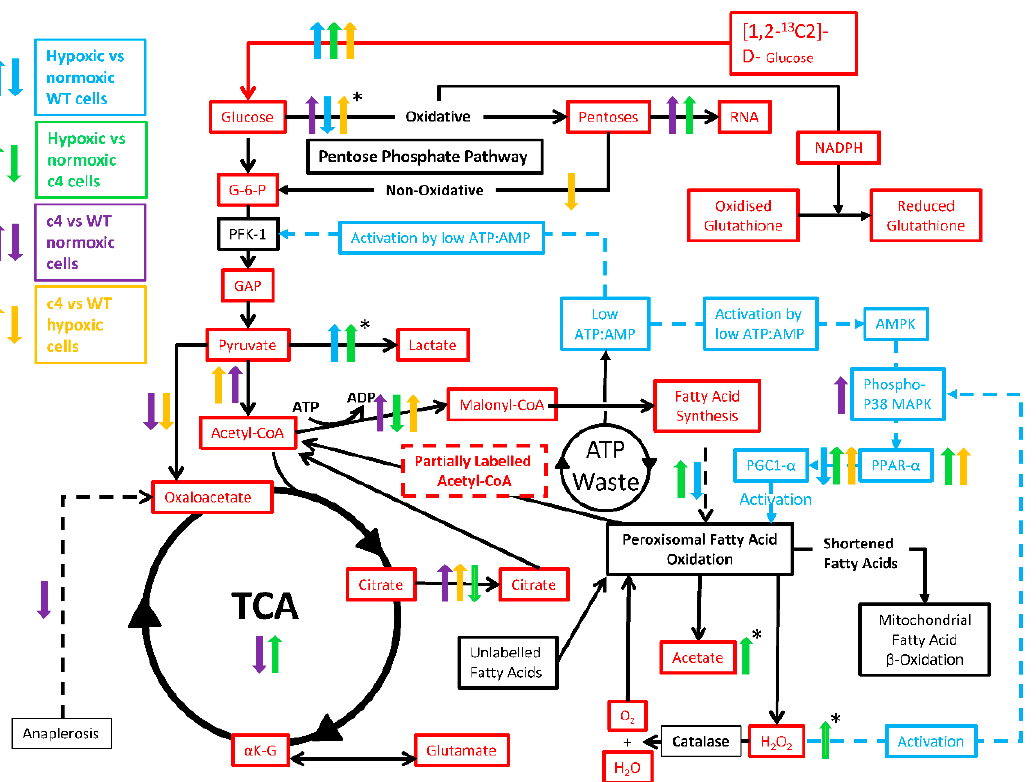
Figure 6. Metabolic fluxes and control factor expression changes in Hepa-1 cells. Solid black lines indicate metabolic pathways; dashed dark-blue lines indicate control mechanisms. Coloured up and down arrows indicate alterations in metabolic fluxes or changes in control factor expression compared with the corresponding parameter in WT or Hepa-c4 cells in normoxia: blue arrows, WT cells in hypoxia vs. normoxia; green arrows, Hepa-c4 cells in hypoxia vs. normoxia; purple arrows, Hepa-c4 cells vs. WT cells in normoxia; orange arrows, Hepa-c4 cells vs. WT cells in hypoxia. Differences in metabolic flux ( ↑ increased flux; ↓ decreased flux) due to HIF deficiency and hypoxia were inferred from changes in the relevant 13 C-labelled isotopomers; * ↑ and * ↓ fluxes were inferred from concentration changes in the substances indicated, not their 13 C-labelling. Arrows pointing upwards suggest significant increase for a given comparison.